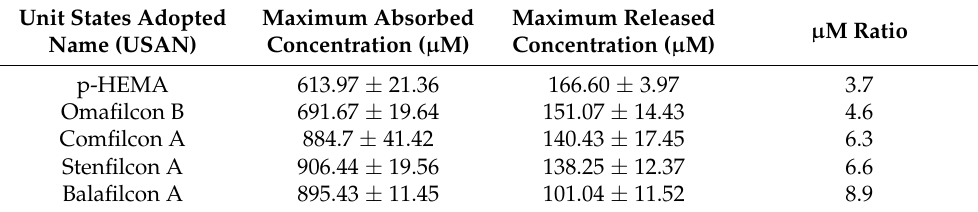
Table 2. The yield of contact lenses loaded with agomelatine as a drug delivery system.